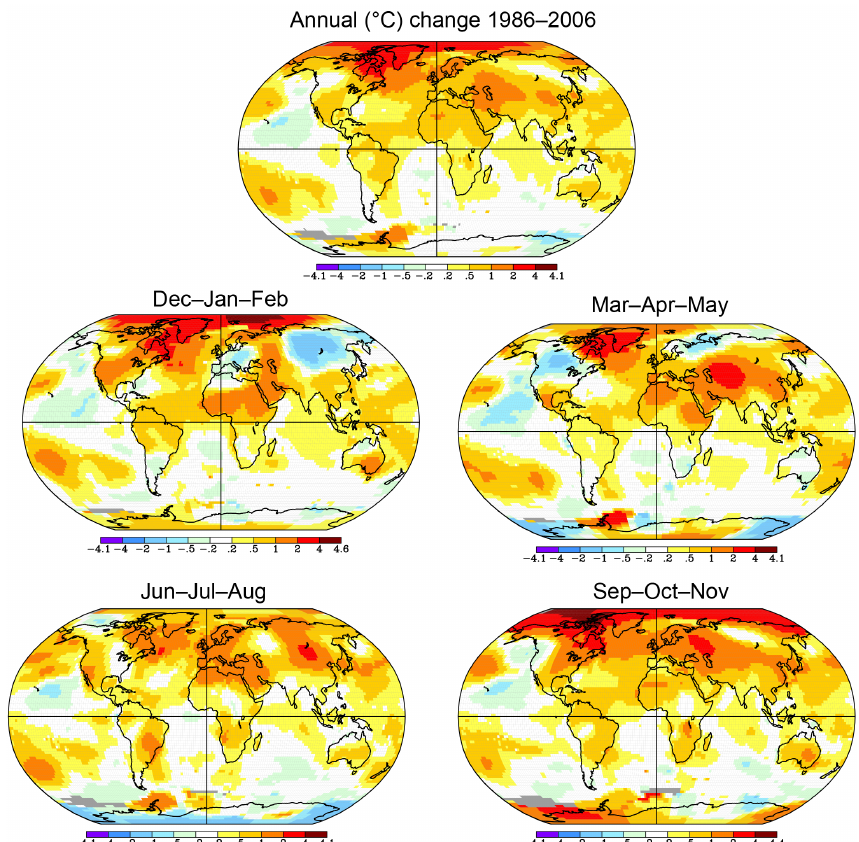
Figure 8. Gridded temporal trends in surface air temperature from the GISS temperature record (http://data.giss.nasa.gov). Plots were made using software available on the data archive website.